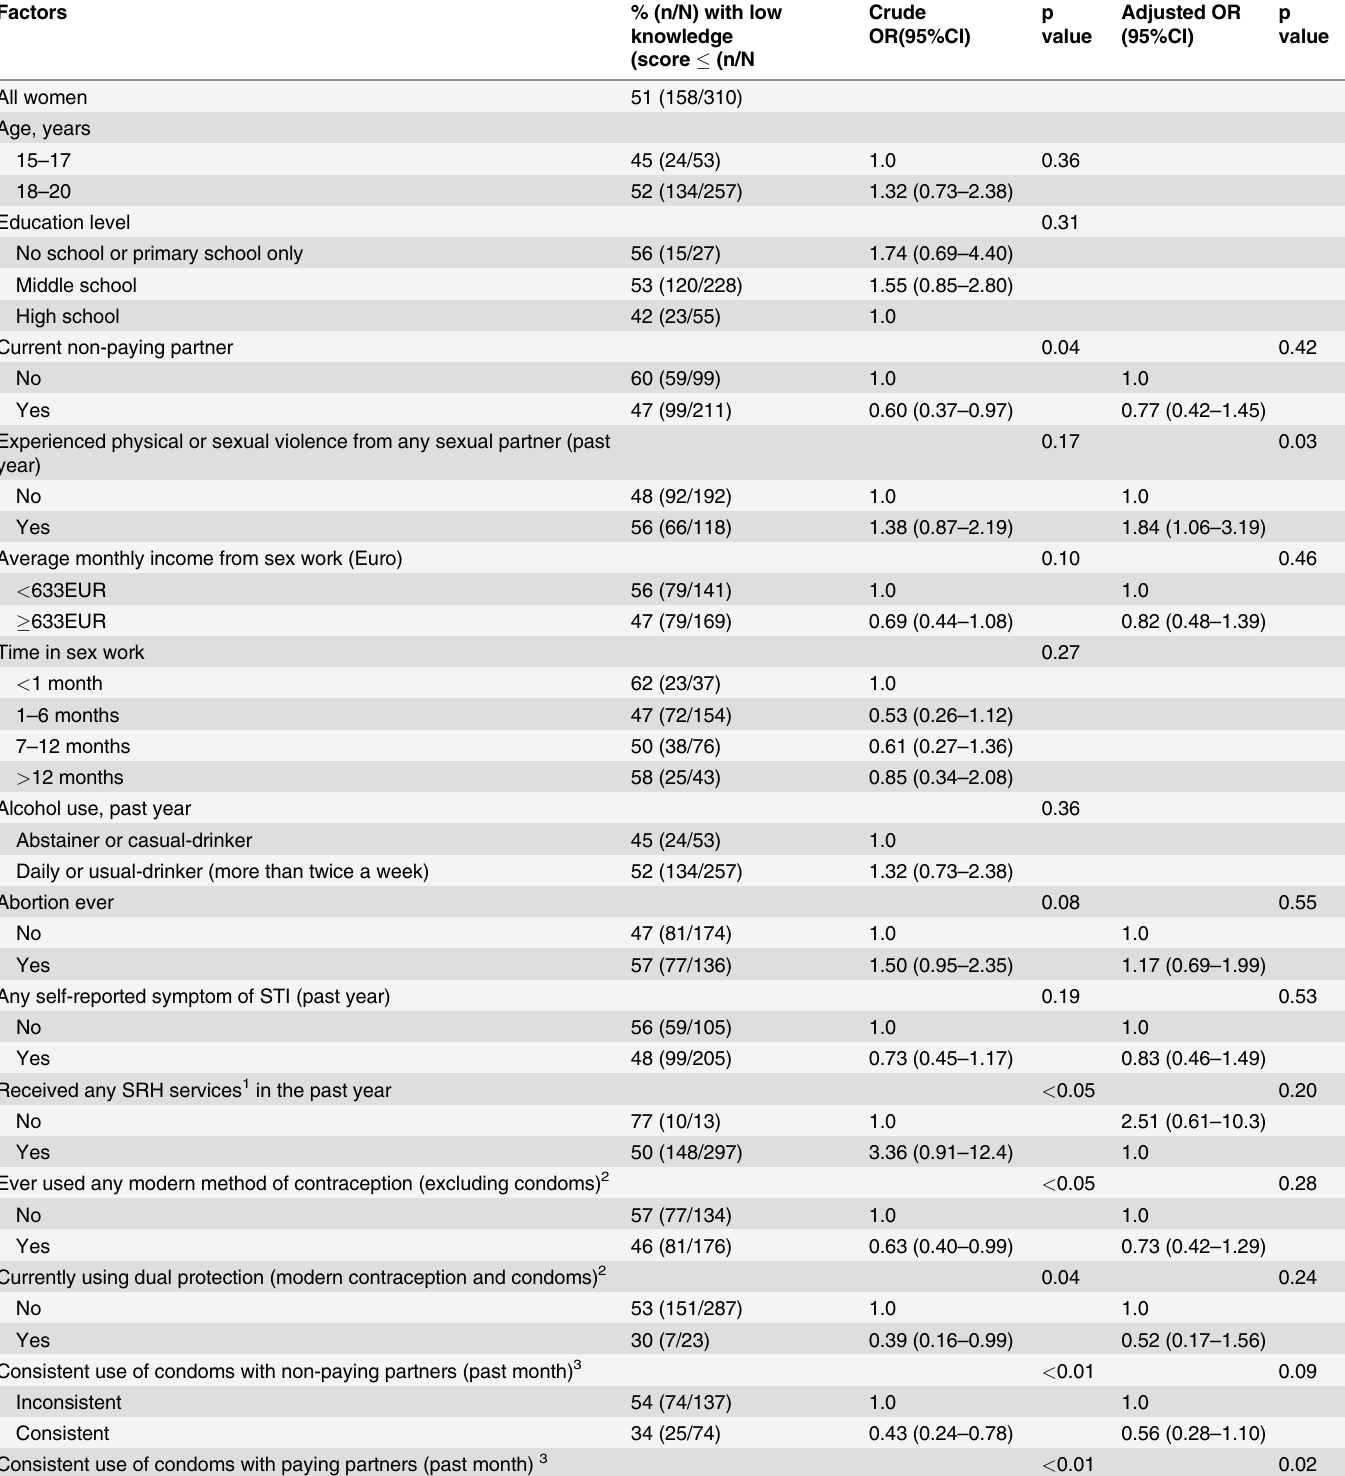
Table 4. Factors associated with lower knowledge of sexual reproductive health among adolescent female sex workers (N =